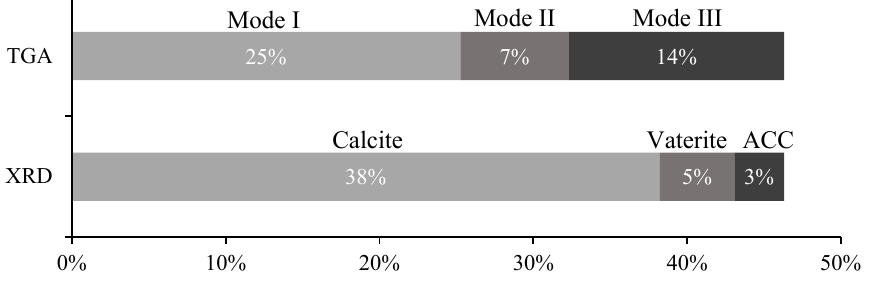
Figure 8. Comparison between TGA and XRD results regarding CC polymorphs produced at 1SP.